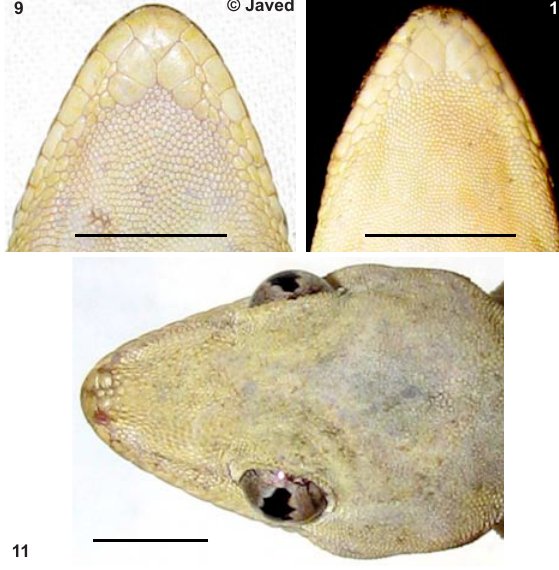
10. Ventral aspect, Hemidactylus cf. frenatus female (NHM.OU.REP.PV.8-2009) (live) head region showing secondary postmentals in contact with infralabials. 11. Dorsal aspect, Hemidactylus cf. frenatus male (ZSI/FBRC/V-1521) (live) showing snout and forehead.